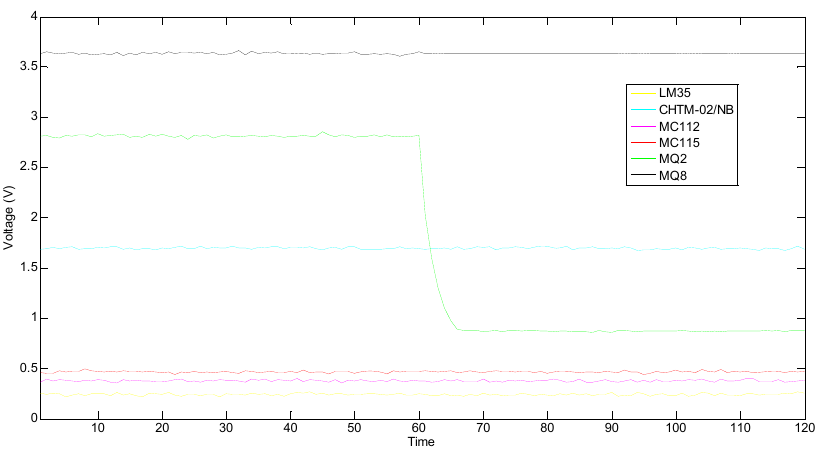
Figure 12. Static outputs when MQ2 is faulty.